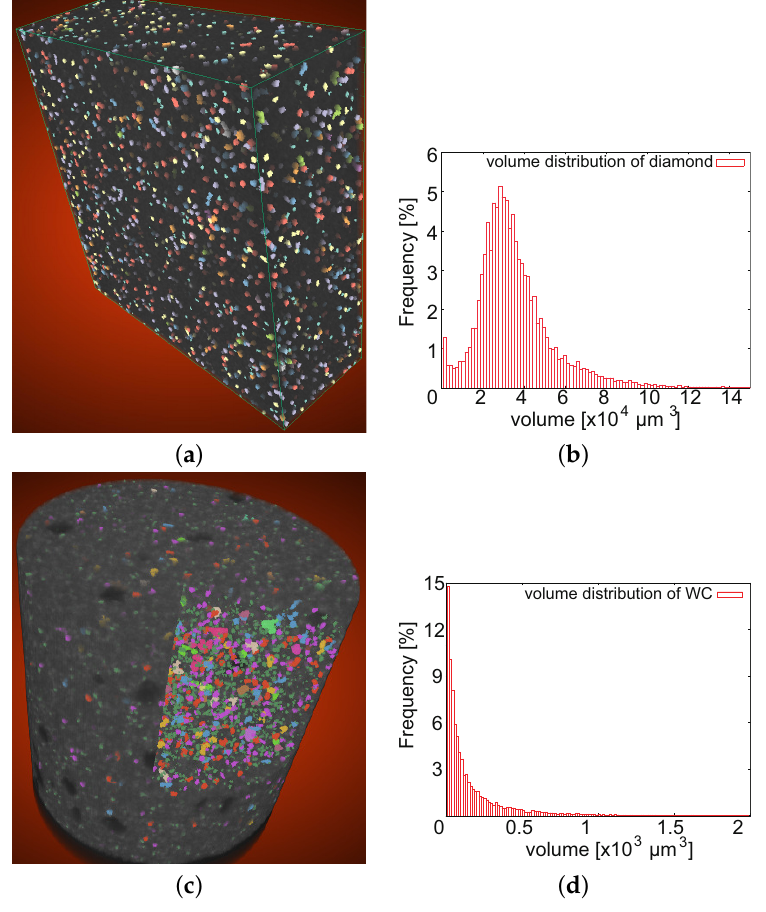
Figure 4. The particles and the size distribution of the diamond and the WC phase (type-II quasi- brittle behavior): ( a ) diamond particles shown in color and reconstructed from tomographic images (scan-A); ( b ) the corresponding diamond size distribution with a mean volume of about 3.6 ( c ) WC particles shown in color and reconstructed from tomographic images (scan-B); ( d ) the WC size distribution corresponding to ( c ) and with a mean volume of about 2